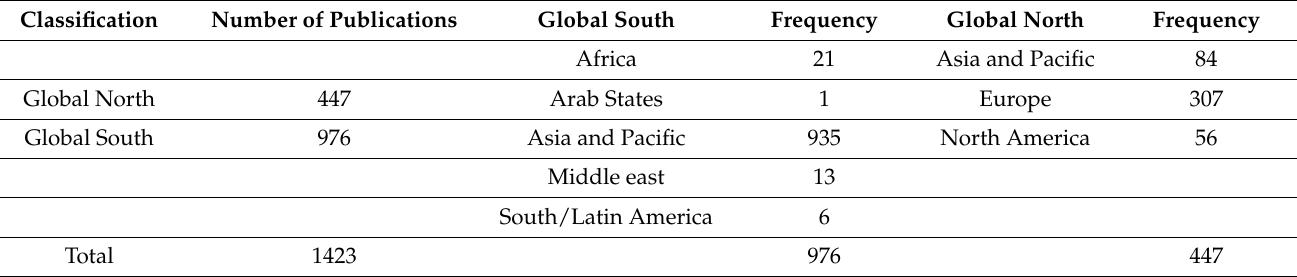
Table 3. Production frequency by continent.